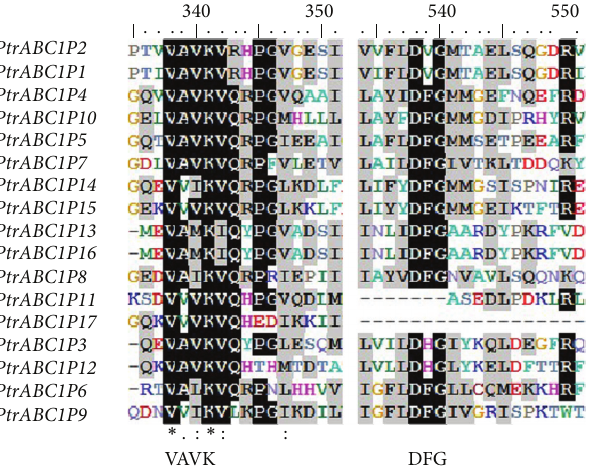
Figure 1: Conserved amino acid conservation sequences in the ABC1 domain of the ABC1P gene family in P. trichocarpa . The multiple alignment of the ABC1 domain was obtained with Clustal X. Fully and partially conserved (present in more than 50% of aligned sequences) residues are highlighted in black and gray, respectively. VAVK and DFG motifs are